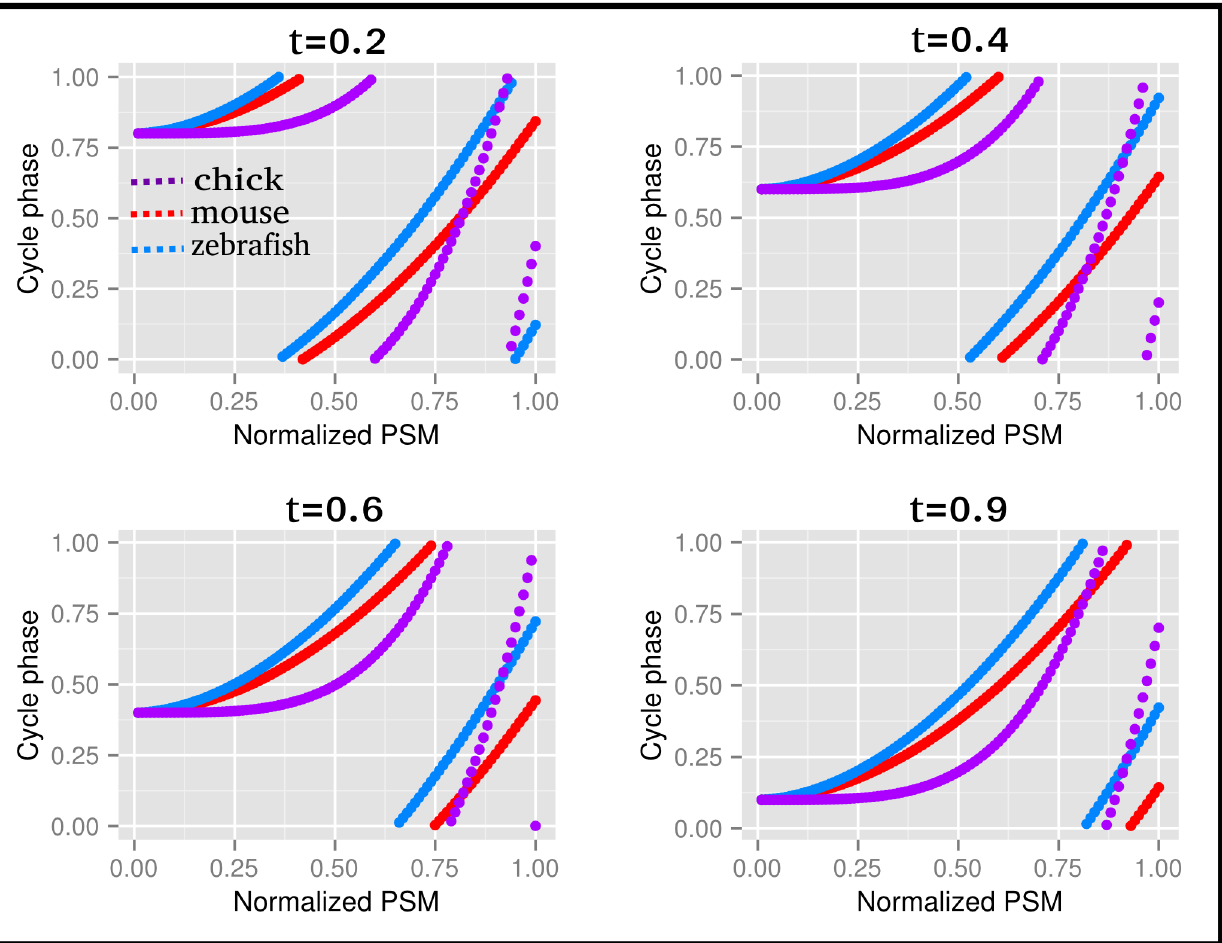
Fig 7. Relationship between the phase of gene expression and position along the PSM of the chicken, mouse and zebrafish embryos. The waves start as moving fast for small values of x (most posterior part of the PSM), and slow down as the wave progresses toward larger values of x . The four snapshots depict a sequence of time-points, corresponding to different phases of the somite cycle.